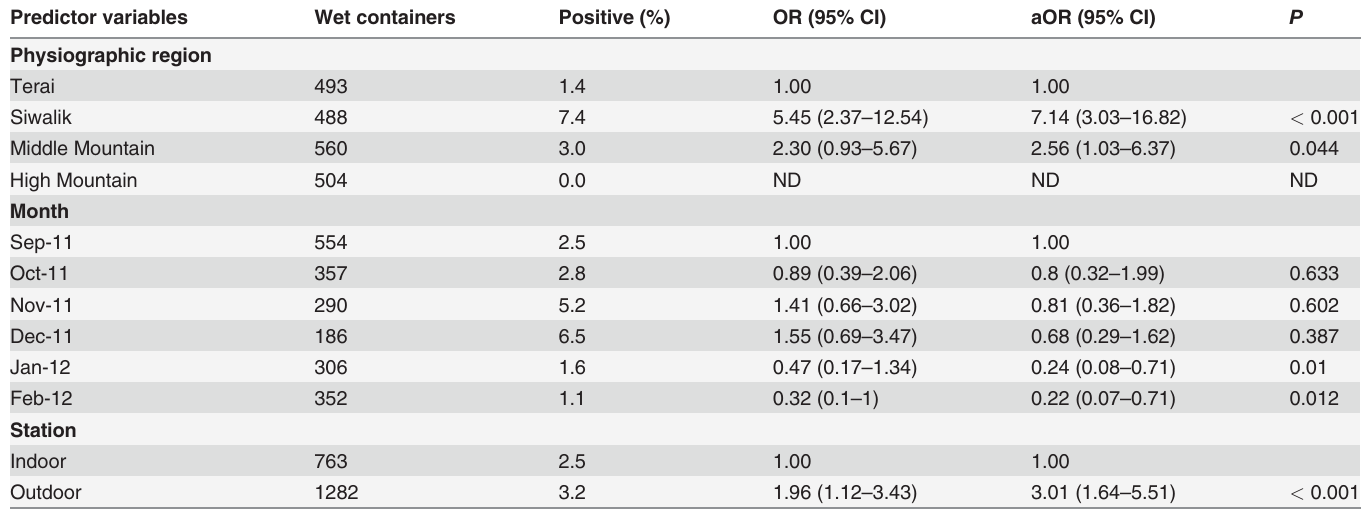
Table 5. Multivariate logistic regression analysis for the co-occurrence of larvae and pupae of Aedes aegypti and Aedes albopictus . Predictor variables Wet